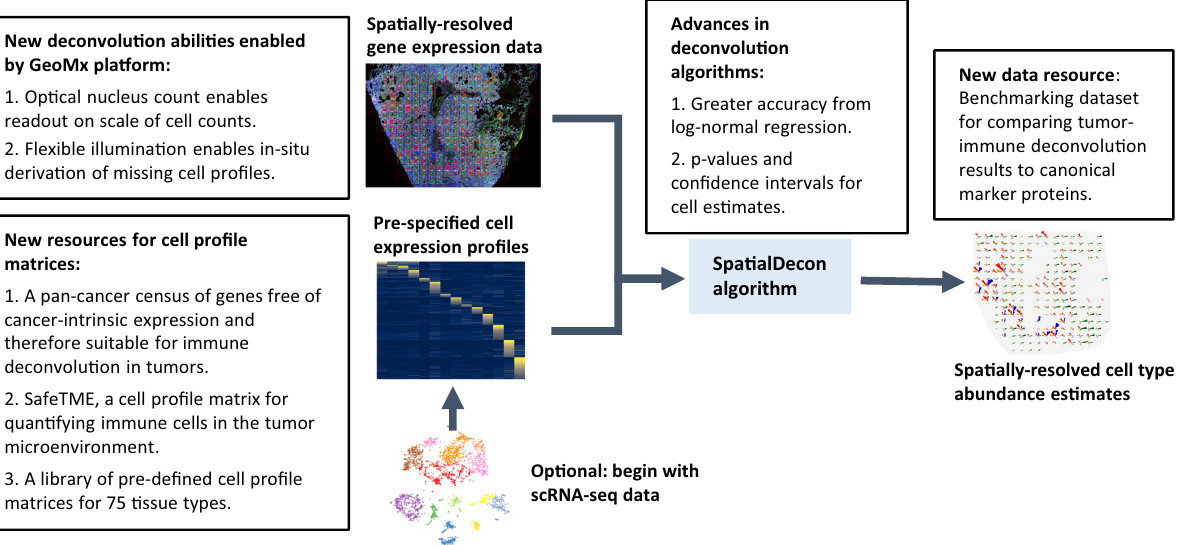
Fig. 1 Overview of algorithm and advancements to the deconvolution fi eld. The image summarizes the deconvolution work fl ow. Text boxes summarize developments proposed in this manuscript. Source data are provided as a Source Data fi